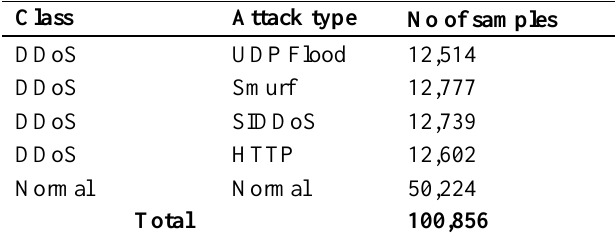
Table 2. Distribution of DDoS Attack and Normal Instances for Training Set.